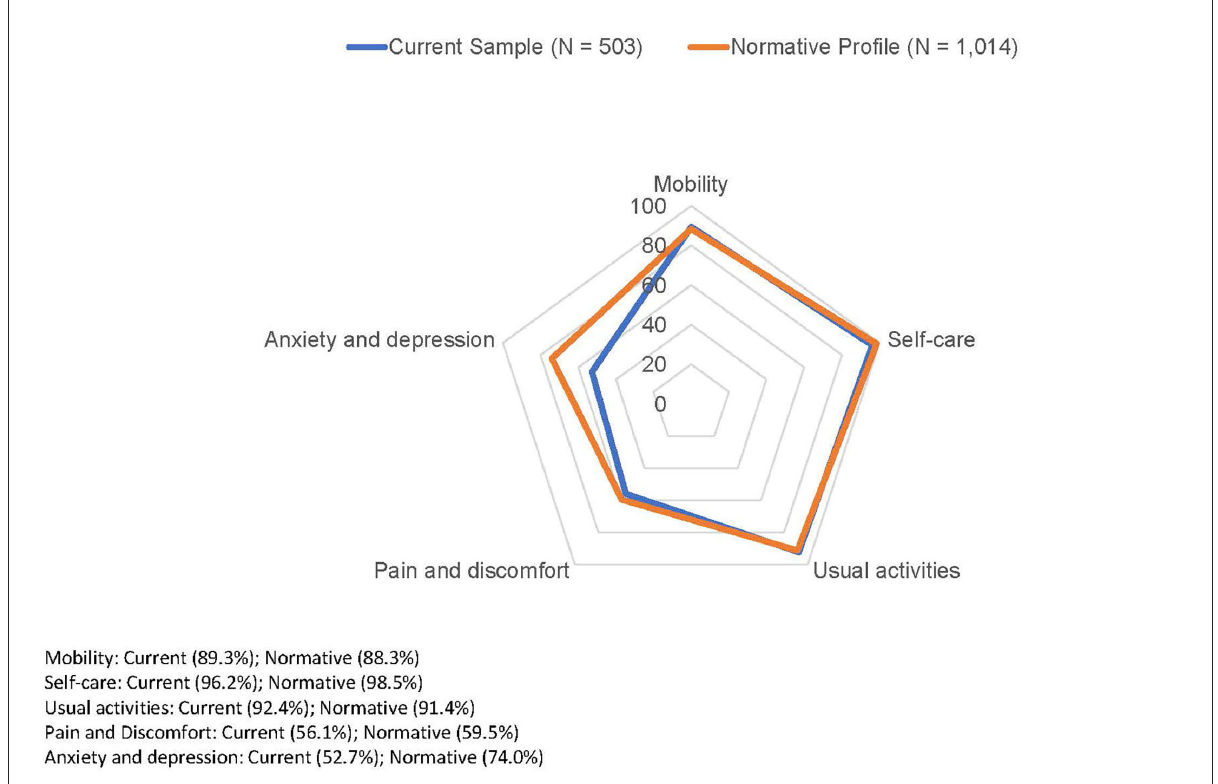
FIGURE1 Percentages of participants reporting have no problem in five domains of EQ-5D-5L compared with HK normative profile.